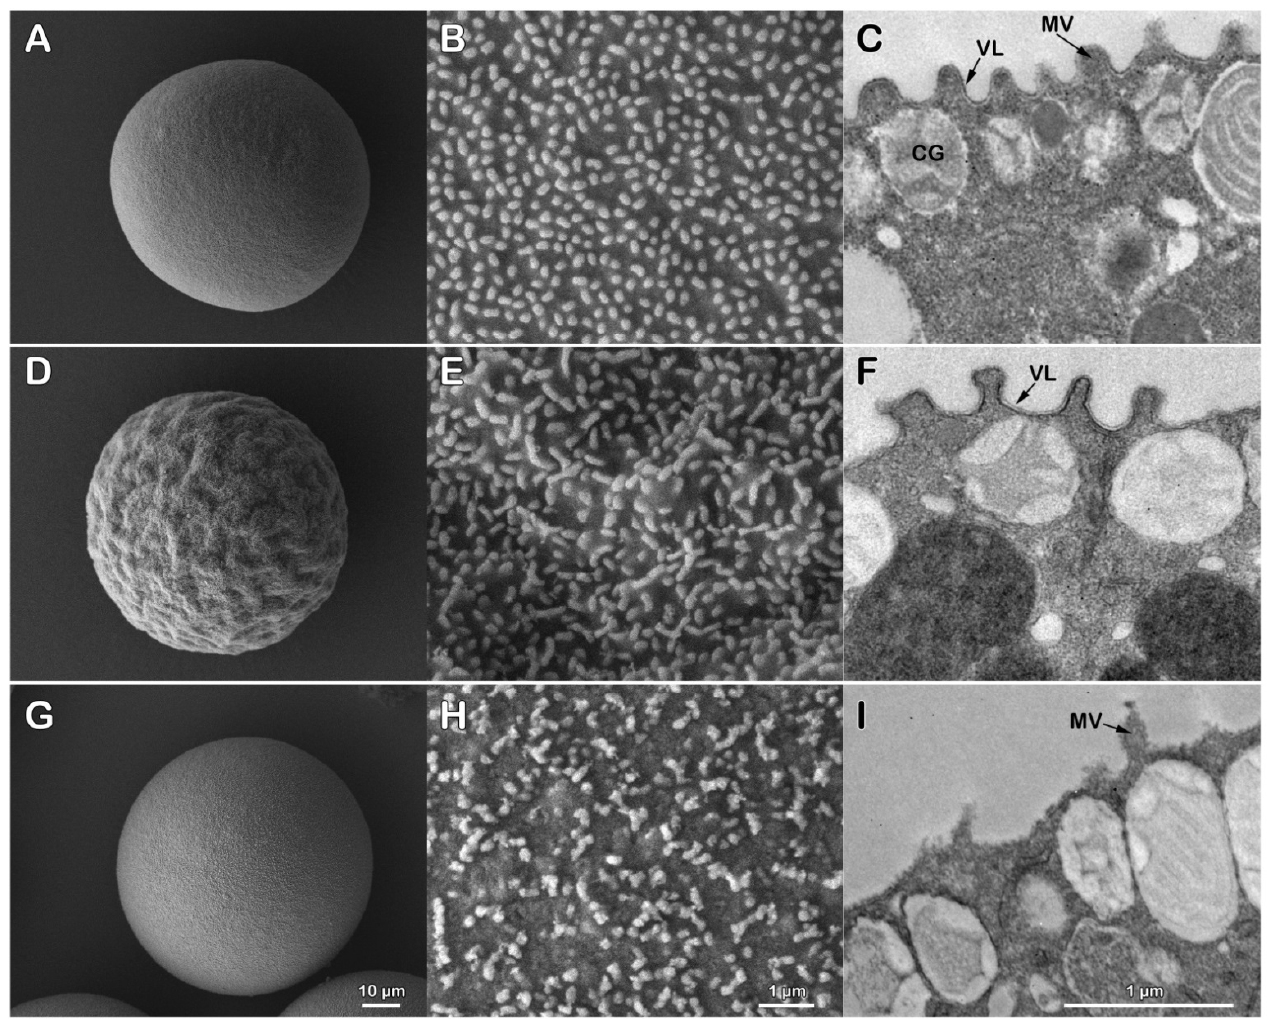
Figure 1. Alteration of the egg surface and microvillar morphology following incubation of P. lividus eggs in acidic seawater (pH 5.5) and after DTT treatment (pH 9) to remove the vitelline and egg jelly. SEM micrographs at lower ( A ) and higher magnification ( B ) of the outer surface of P. lividus eggs fixed after incubation in NSW (pH 8.1). Note the microvilli are regularly arranged on the smooth outer surface of the eggs. TEM observations ( C ) reveal the vitelline layer (VL) covering the microvilli (MV) in the absence of the jelly coat, which was not preserved in the eggs following the fixation procedure. Cortical granules (CG) are seen attached to the egg plasma membrane. Five minutes of incubation of the eggs in acidic seawater induced morphological alteration of the egg cortex, evidenced by the shrinkage of the cell volume shown in the SEM images in ( D , E ). The ultrastructural analysis revealed that, after incubating the eggs in acidic seawater, they still possessed the VL attached to the egg plasma membrane ( F ). The incubation of the eggs in NSW containing 10 mM of DTT for 20 min (pH 9) induced a dramatic alteration of the surface of the egg and microvillar morphology. SEM micrographs in ( G , H ) show that such treatment heavily damaged the egg surface and reduced the number of microvilli without changing the cell volume. In addition to the structural alteration of the microvilli, the DTT treatment completely removed the VL from the egg plasma membrane, as shown in the TEM image ( I ).